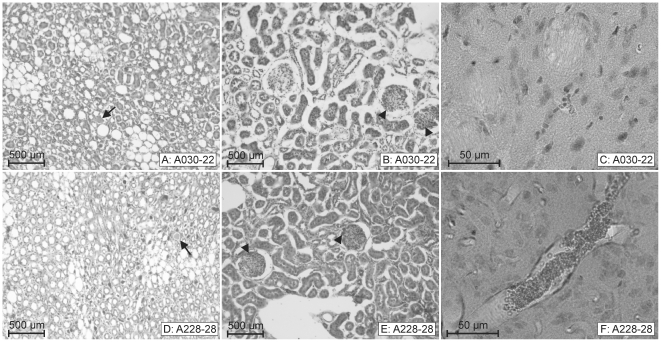
Two SHRSP with comparable peritubular erythrocyte aggregations, but a different extent of cerebral erythrocyte accumulations.
A–C: SHRSP aged 22 weeks (animal 30). D–F: SHRSP aged 28 weeks (animal 228). Both animals exhibit comparable peritubular erythrocyte aggregations in kidney medulla (visible as red dots in A
&
D) as well as comparable glomerular erythrocyte sticking in kidney cortex (black arrow heads in
B
&
E). The medulla of both kidneys additionally contains few tubular protein cylinders (black arrows in
A
&
D). In contrast to the similar kidney pathology animal 30 exhibits in the brain only a marginal number of capillaries with accumulated erythrocytes (here basalganglia, C), whereas in animal 228 those accumulated erythrocytes are already found in cortical arterioles (F) and in arterioles of other brain regions (not shown). A030-22: animal number 30, 22 weeks old.